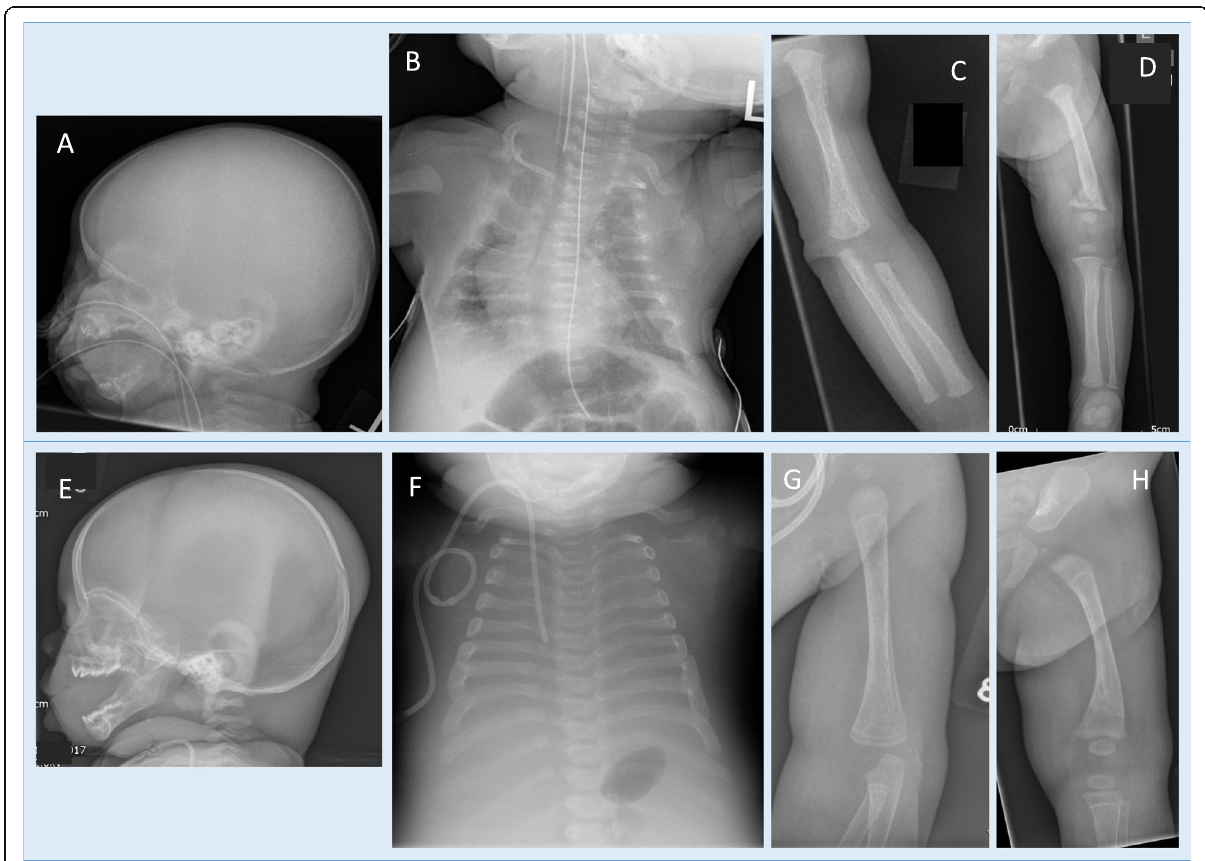
Fig. 1 Radiological findings. Upper panel ( a - d ) shows early postnatal plain radiographs (Day 12) and lower panel ( e - h ) shows corresponding post- mortem plain radiographs. Bone density is considerably less in each upper panel image compared with lower images (skull a and e , chest b and f , upper limb c and g , lower limb d and h ). Chest X-rays ( b and f ): thoracic size is extremely reduced ( b ), to a lesser degree post-mortem ( f ), which also shows broad and more calcified ribs, although with irregularities posteriorly and laterally consistent with healed fractures. Upper limb: early postnatal imaging ( c ) shows ill-defined metaphyses; then ( g ) more sharply defined metaphyses, prominent growth restart lines in diaphyses and bone-in-bone appearance. Lower limb: d shows initial poorly defined metaphyses, reduced bone density and metaphyseal fractures; then H shows healed fractures, better metaphyseal delineation, prominent growth restart lines in diaphyses and bone-in-bone